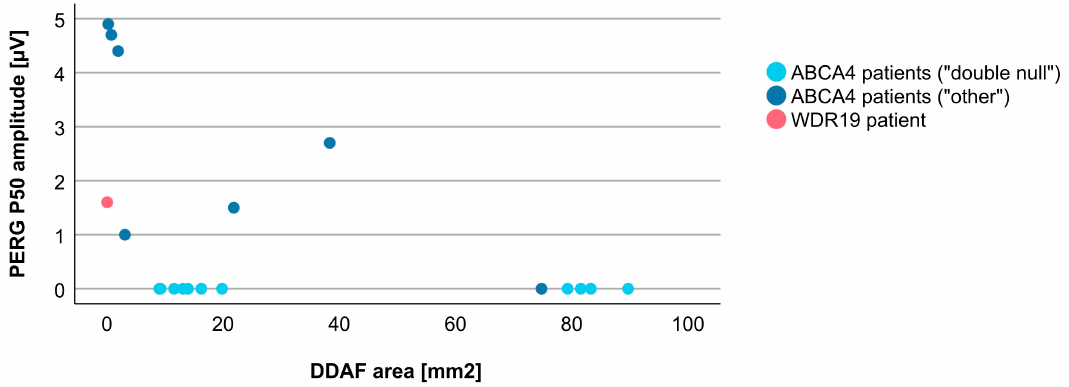
Figure 13. Different ratios of RPE and photoreceptor impairment in WDR19 patient (red), double null ABCA4 patients (light blue) and ABCA4 patients with other genotypes (dark blue). For this analysis a limited number of “other” ABCA4 patients (only those harboring ABCA4 variant c.5714+5G>A (p.[=,Glu1863Leufs * 33]) was included (see Materials and Methods).